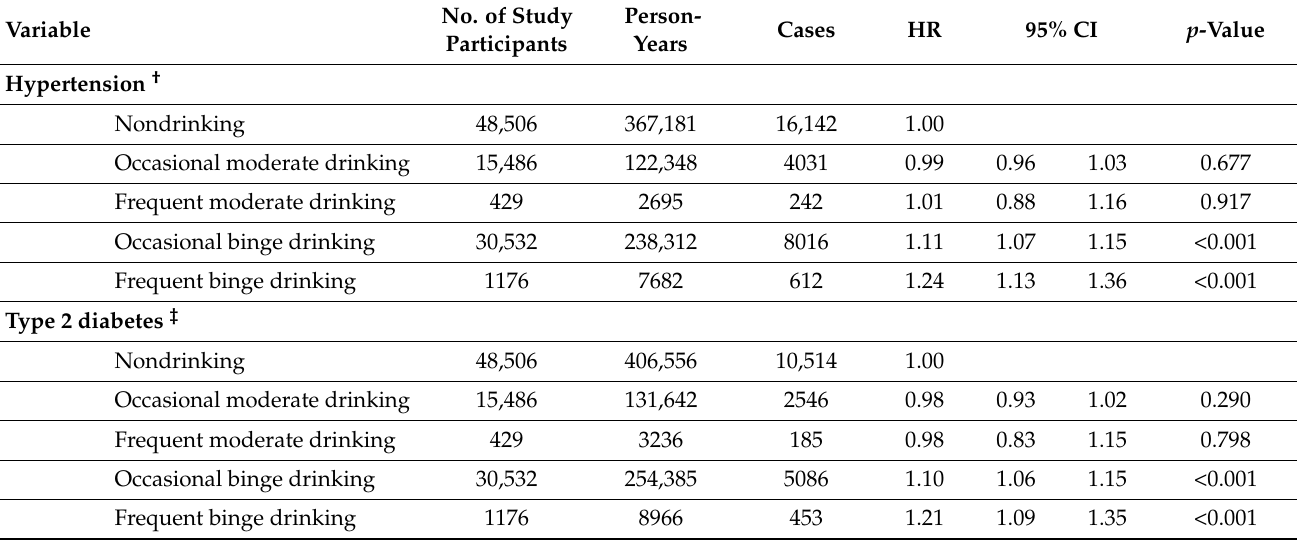
Table 2. The risk of developing hypertension and type 2 diabetes in relation to alcohol consumption.